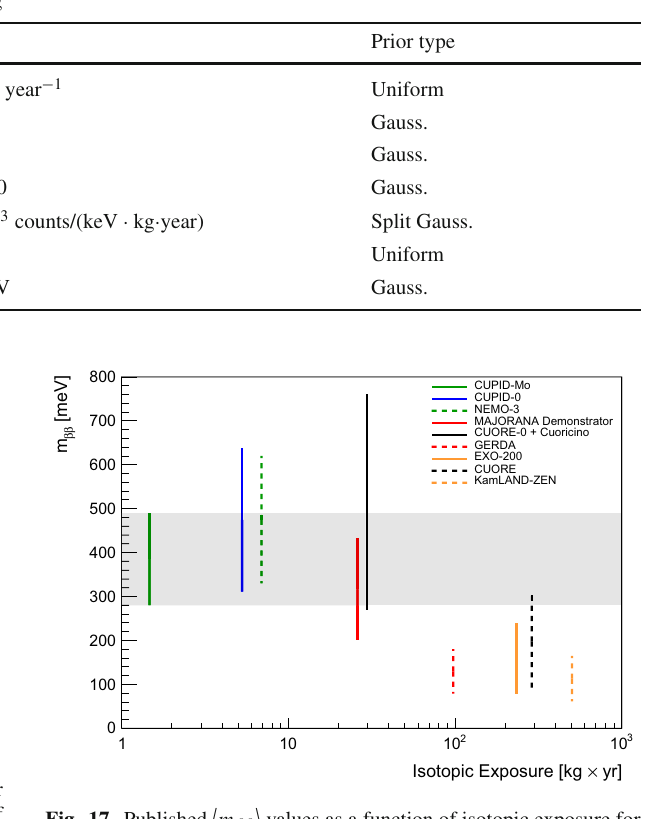
to the different asymmetric uncertainty values. The signal rate is treated as a uniform prior in the positive domain